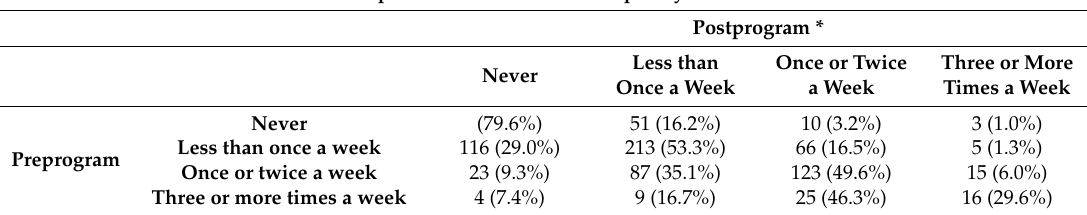
Table 3. The number of participants reporting never, less than once a week, once or twice a week and three or more times a week relating to fast food meal frequency. Percentages refer to the percentage of the specific preprogram